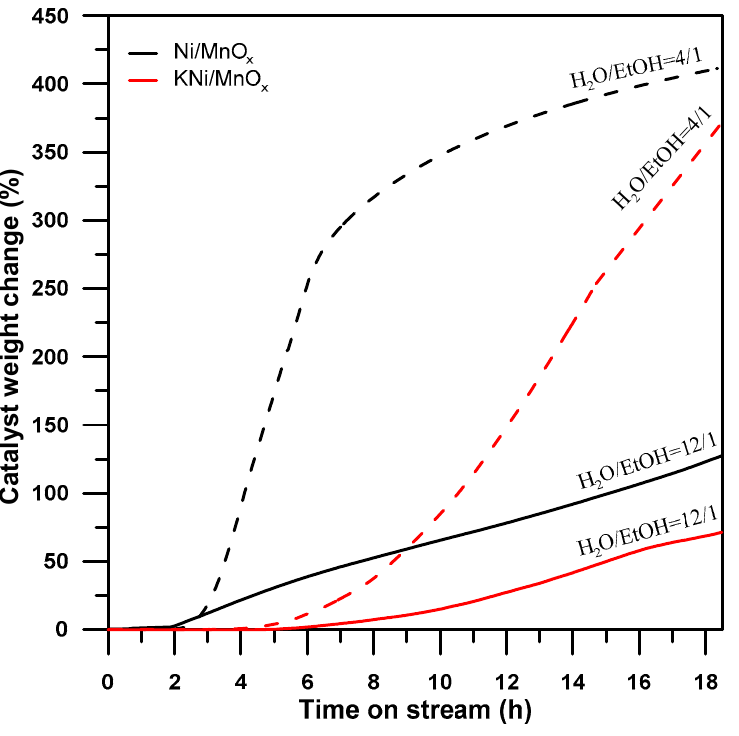
Figure 12. Changes in Ni/MnO x and KNi/MnO x catalysts’ weight under SRE conditions at H 2 O/EtOH molar ratio = 12/1 (straight line) and H 2 O/EtOH molar ratio = 4/1 (dashed line) at 420 °C.